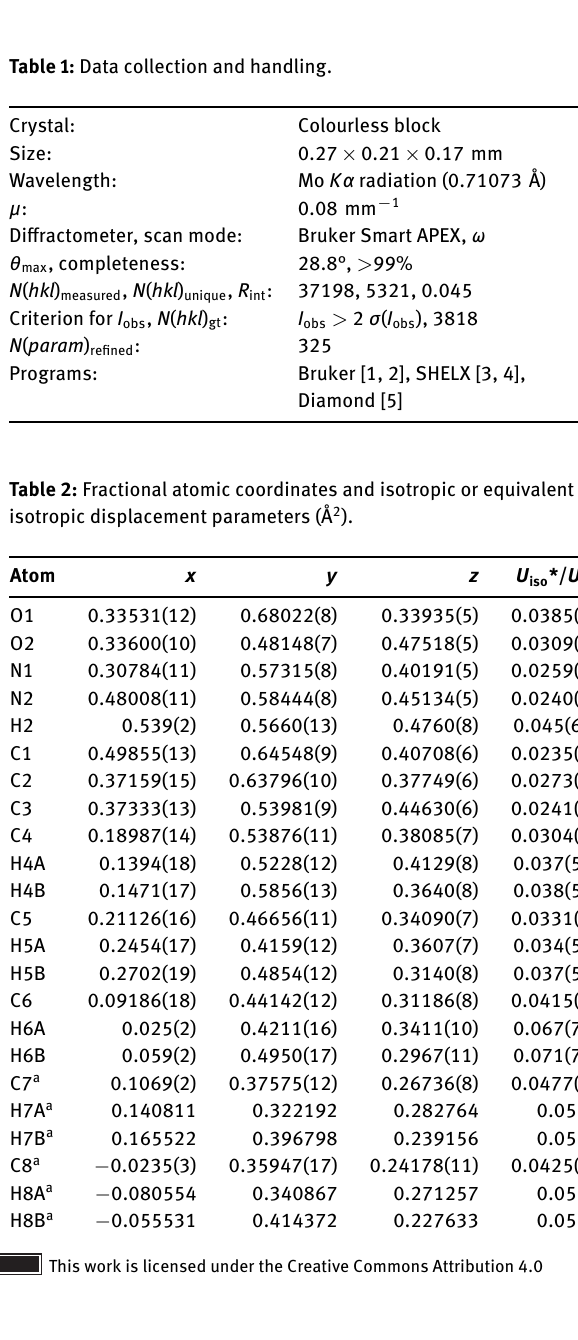
The molecular structure is shown in the figure. Table 1 contains crystallographic data and Table 2 contains the list of the atoms including atomic coordinates and displacement